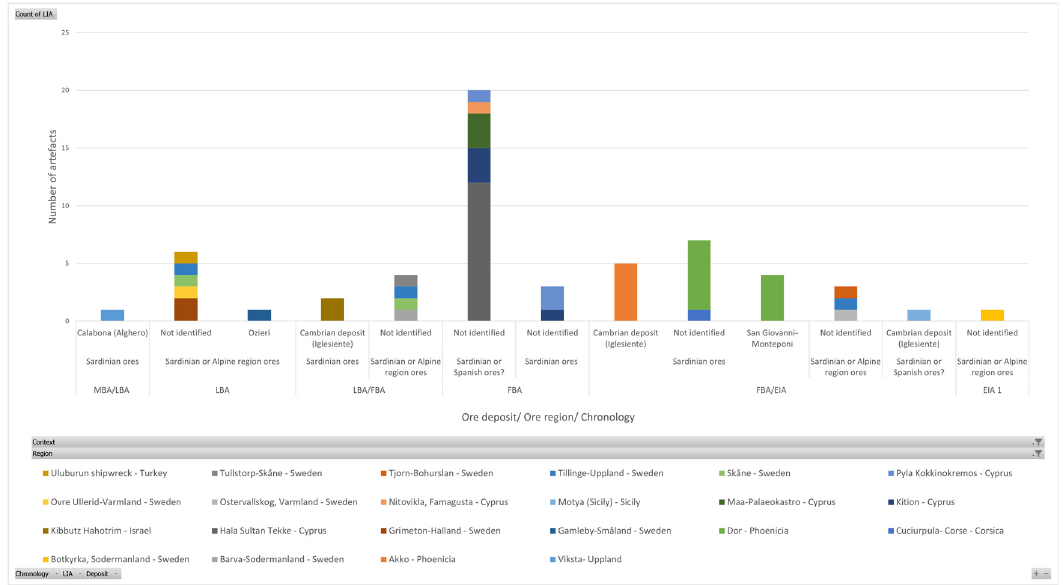
Figure 9: Sardinian metal found abroad. The table summarizes the number of artefacts and their provenance. Nuragic metal ores have been traced through LIA in the Mediterranean and Europe in the BA and EIA. In the graph, there is no distinction between raw material ( e.g., ingots ) and artefacts. In the case of Sweden, the data refer to the publication of Ling et al. ( 2014 ) . However, recently Melheim et al. ( 2018 ) and Nørgaard et al. ( 2019 ) have argued that the more plausible copper source for the Swedish artefacts was in the Alpine region ( Data source: Bernabale et al., 2019; Eshel et al., 2019; Ling et al., 2014; Stos - Gale & Gale, 2010; Wachsmann, 2020; Plot: Valentina Matta © )